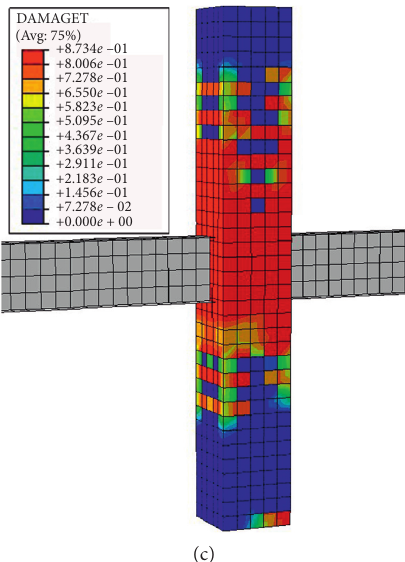
Figure 19: Failure mode of specimen SRC-3. (a) Final cracking. (b) Buckling in beam flange. (c) FEM result.